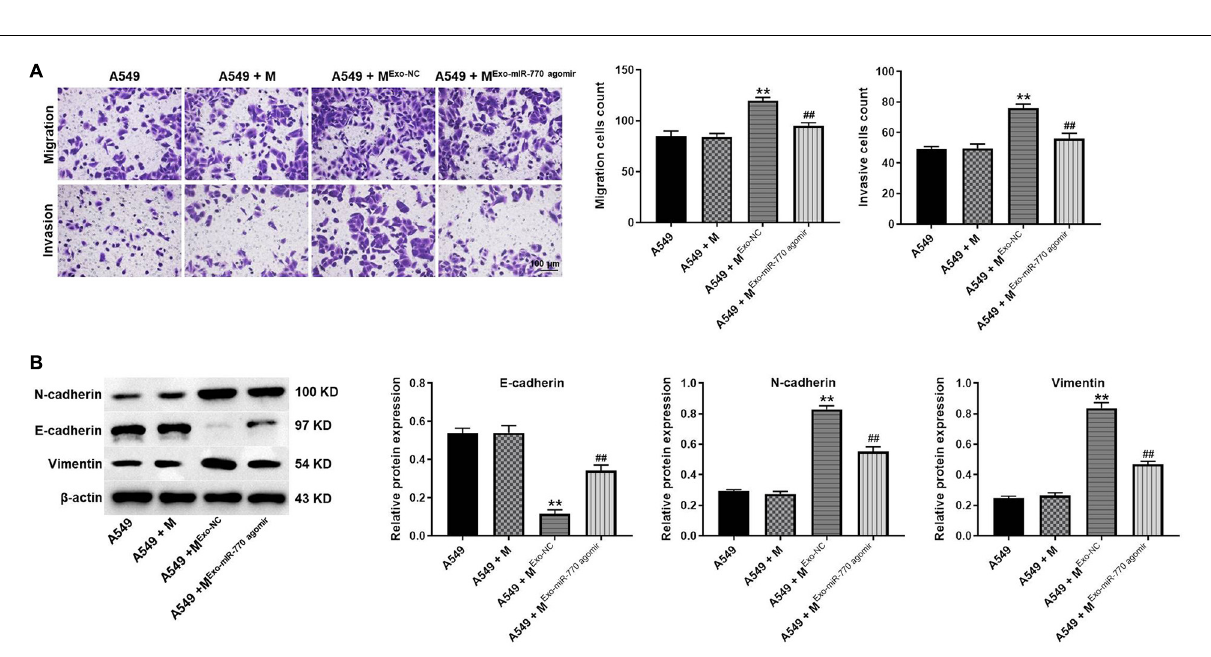
Frontiers in Cell and Developmental Biology |